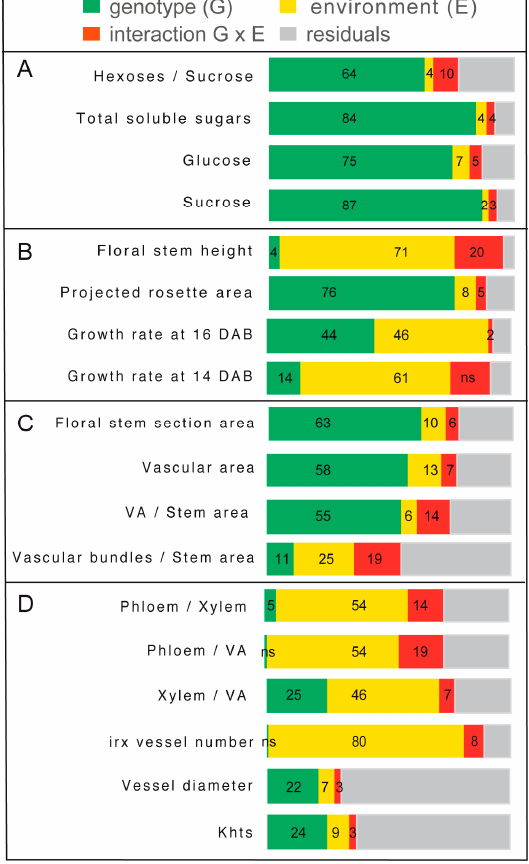
effects ( p < 0.05) are indicated directly in the graph (ns for not significant effects). ( A ) Traits relative to the stem sugar content. ( B ) Growth traits of the rosette and stem. ( C ) Stem anatomic traits. ( D ) Traits relative to the stem vascular